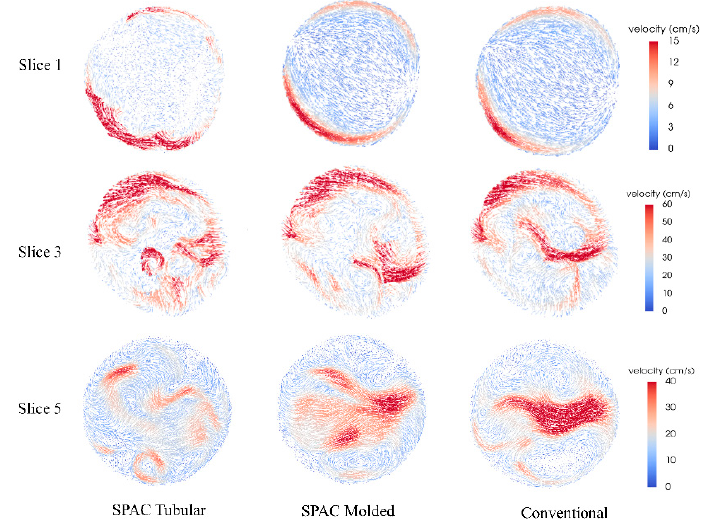
Figure 9. The secondary flow velocity vector distributions of all three cases at t 4 .